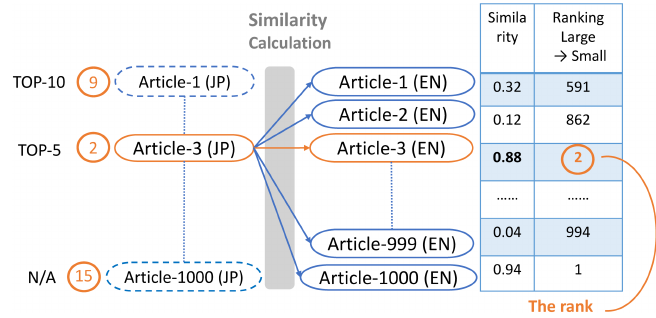
Figure 3. Illustration of an evaluation procedures using ranks and TOP-N